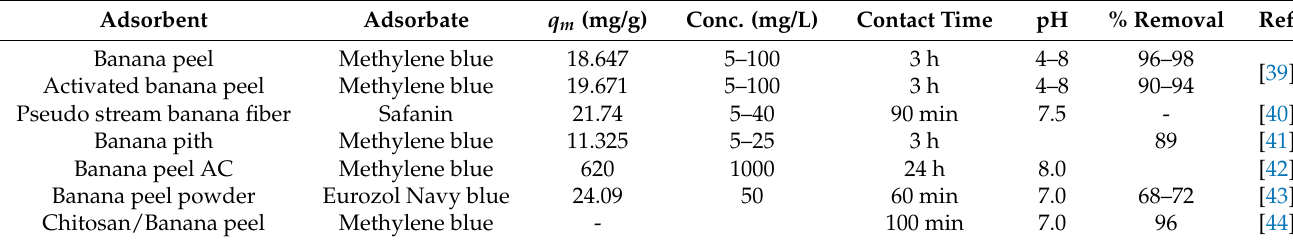
Table 3. Adsorption Capacities of banana waste-based adsorbent for the removal of dyes.